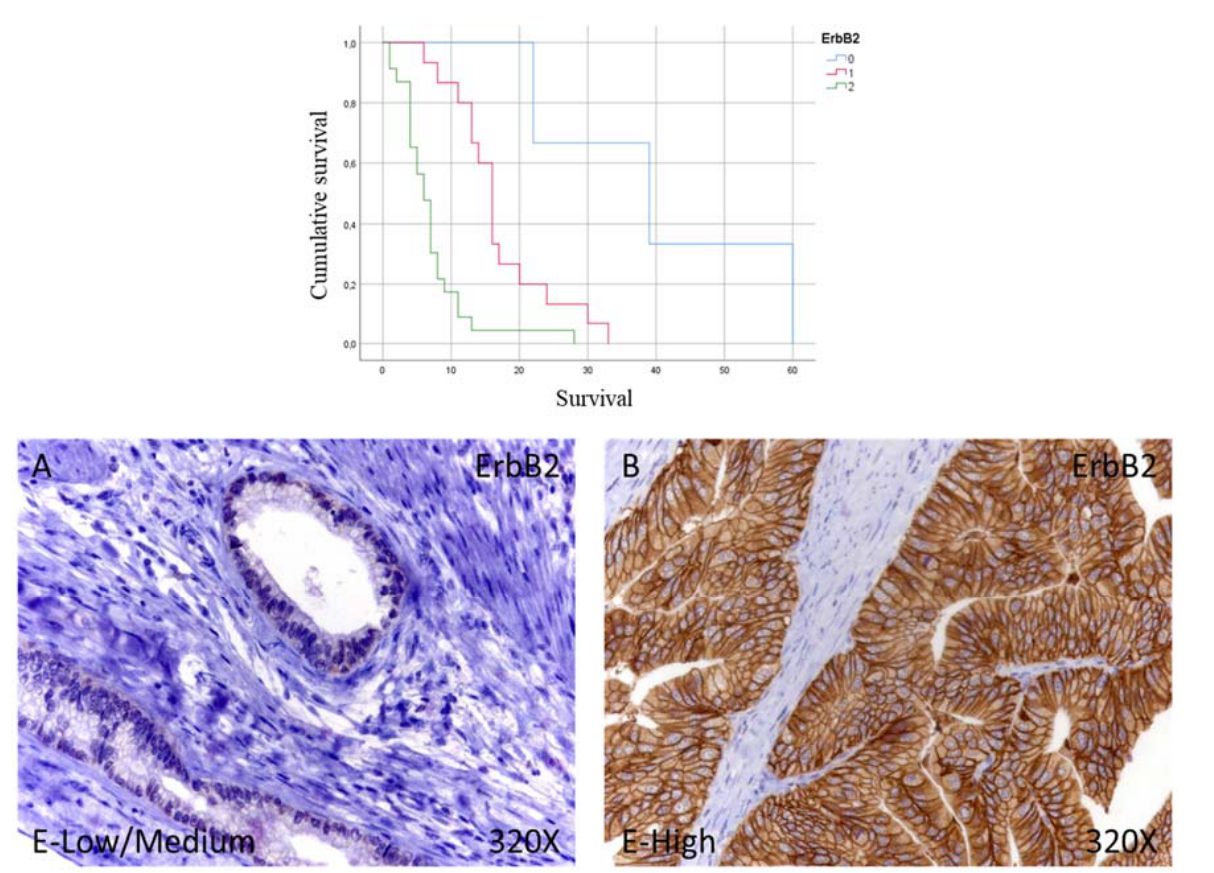
Figure 3. Kaplan–Meier curves for survival time according to tumor expression ( top ) and images showing the protein expression of Erb2 in patients diagnosed with pancreatic cancer ( bottom A – B ). E-Low/Medium = tissue expression classified as low/medium; E-High = tissue expression classified as high; 320× magnification. Histological samples from patients diagnosed with pancreatic cancer were classified as negative expression (0), low/medium (1), and high (3) using the IRS-Score method n = 41.